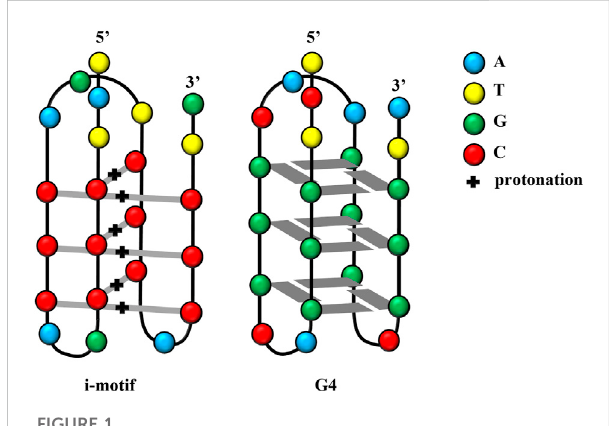
FIGURE 1 Structures of the i-motif and